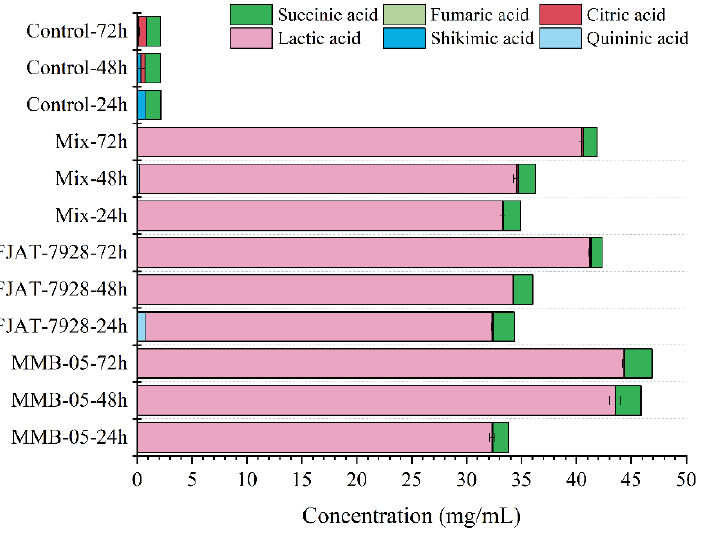
Figure 6. Changes in organic acid contents during LAB stains fermentation of P. yezoensis sauce.